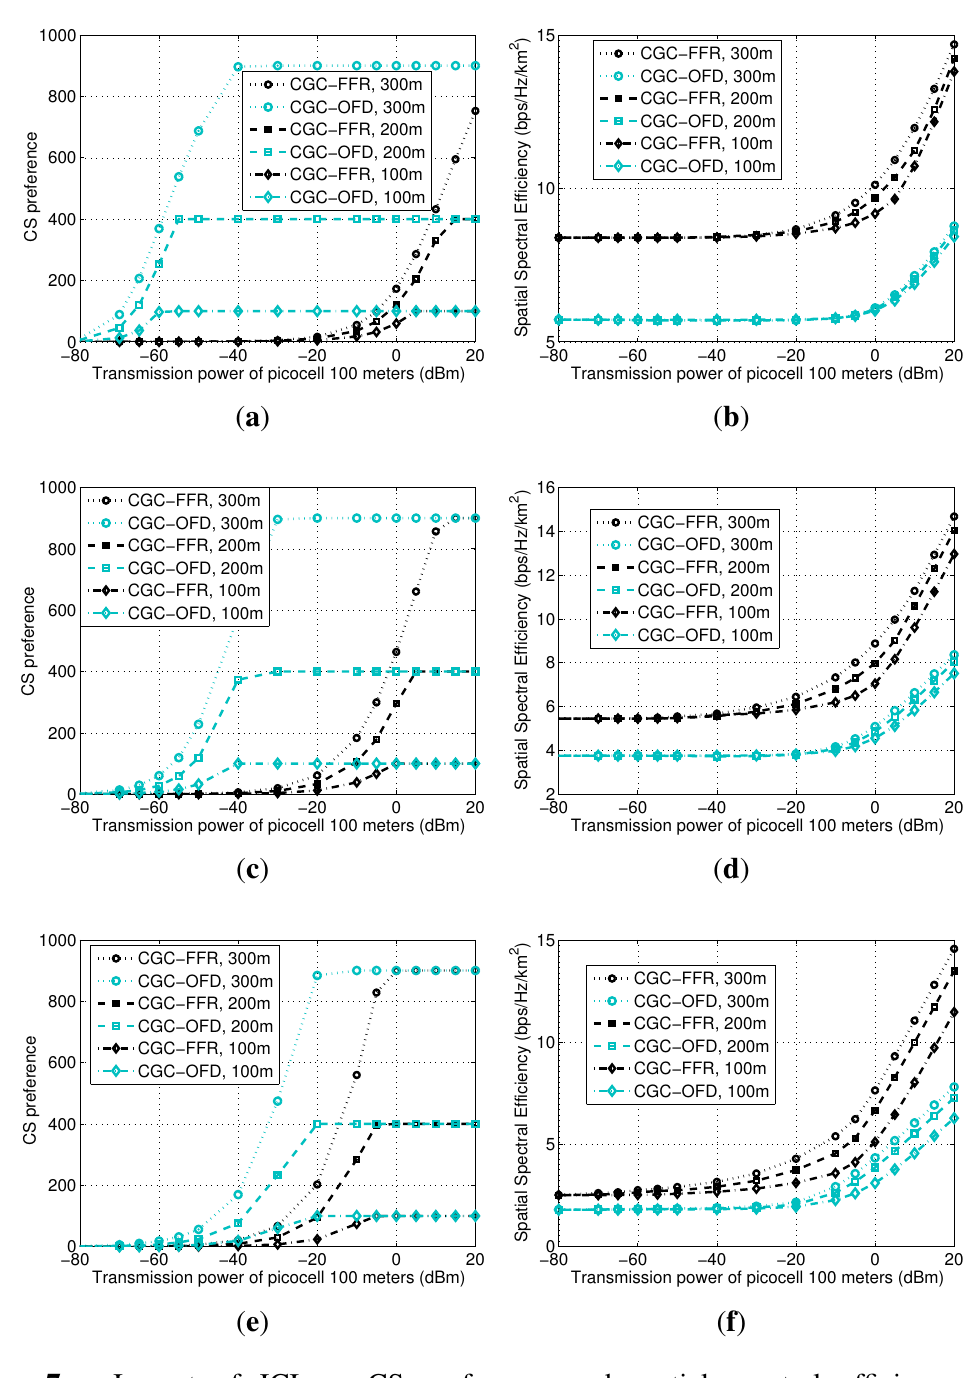
Figure 7. Impact of ICI on CS preference and spatial spectral efficiency using CGC-fractional frequency reuse (FFR) and CGC-orthogonal frequency division (OFD). ( a ) Path Loss 2 (free space); ( b ) Path Loss 2 (free space); ( c ) Path Loss 3 (suburbs); ( d ) Path Loss 3 (suburbs); ( e ) Path Loss 4 (downtown); ( f ) Path Loss 4